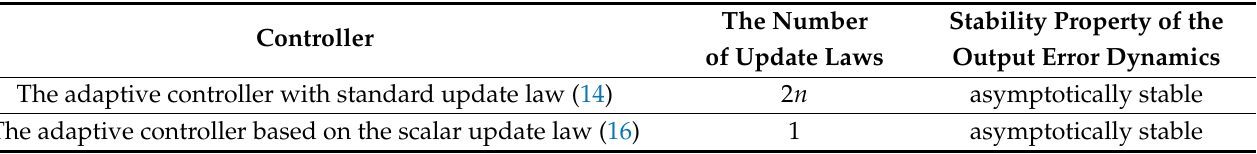
Table 2. The comparison of computation and stability